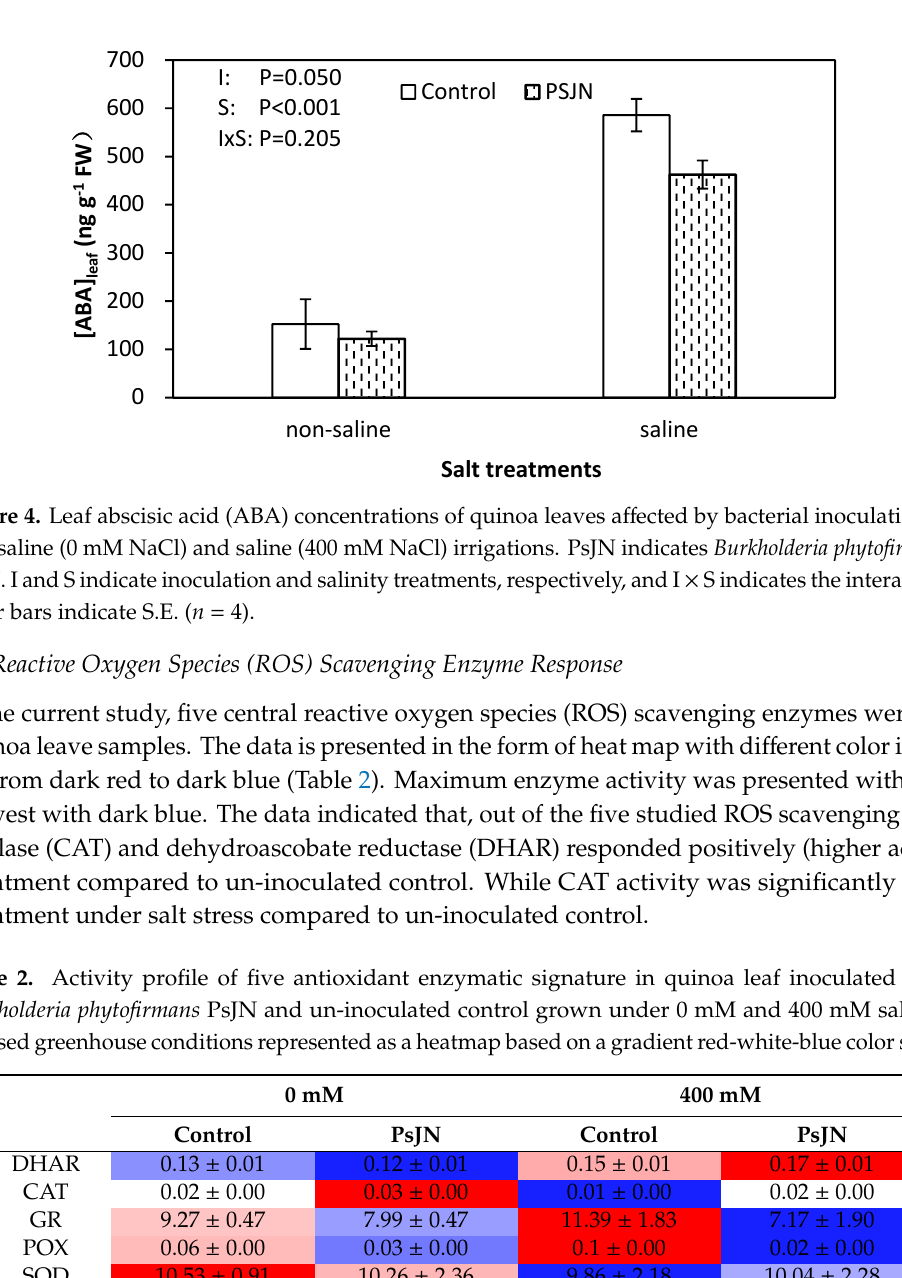
Figure 3. Leaf Na + ( a ) and K + ( b ) concentration of quinoa leaves affected by bacterial inoculation in non-saline (0 mM NaCl) and saline (400 mM NaCl) irrigations. PsJN indicates Burkholderia phytofirmans PsJN . I and S indicate inoculation and salinity treatments, respectively, and I x S indicates the interaction. Error bars indicate S.E. ( n = 4).